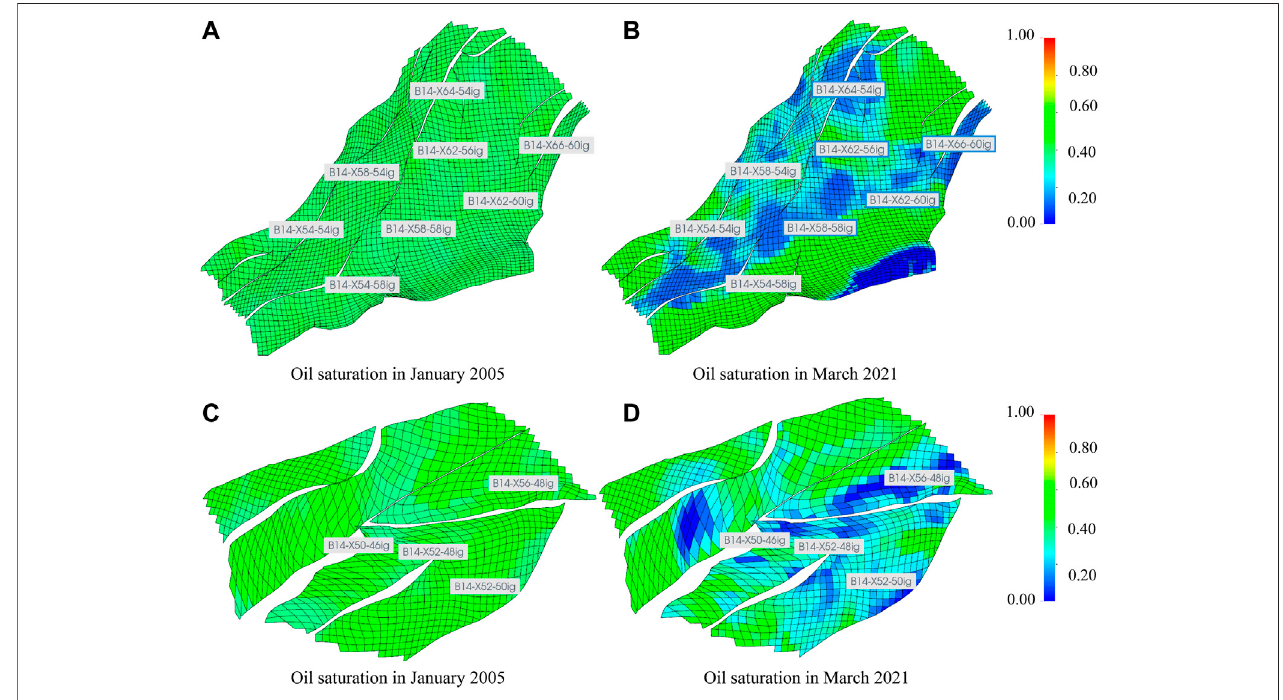
FIGURE 6 | (A,B) Oil saturation of simulated layer 16 in SU12; (C,D) oil saturation of simulated layer 20 in B1.